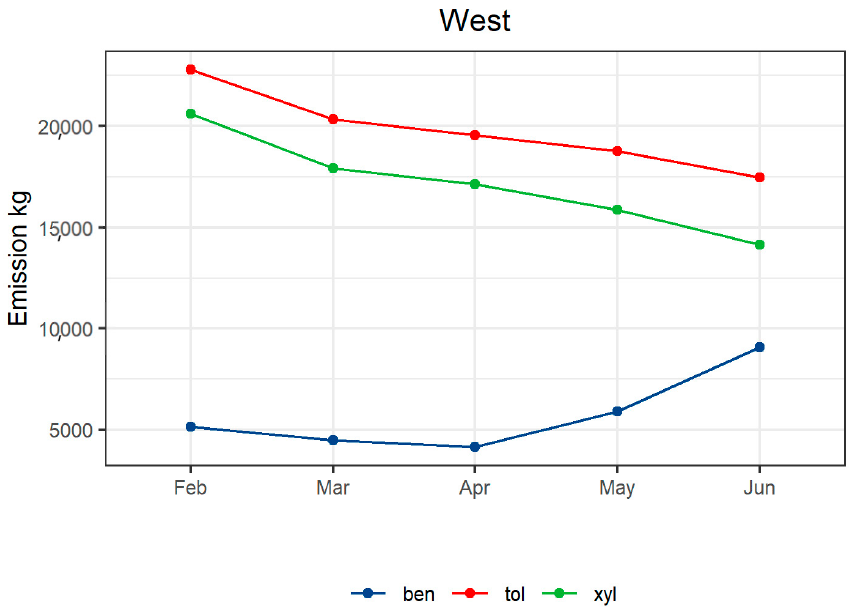
Figure 12. Monthly emissions from the NSW emission inventory from the suburbs located west of the sampling site. Ben: benzene, tol: toluene and xyl: xylene.